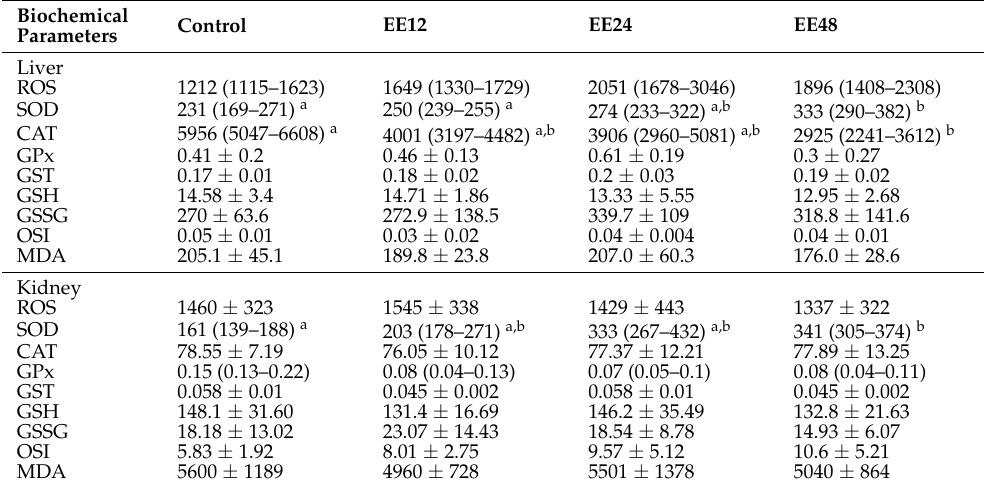
Table 4. Values of liver and kidney oxidative parameters. Data are expressed as mean ± standard deviation for parametric data distribution or median (25th–75th quartile) for non-parametric data. Biochemical